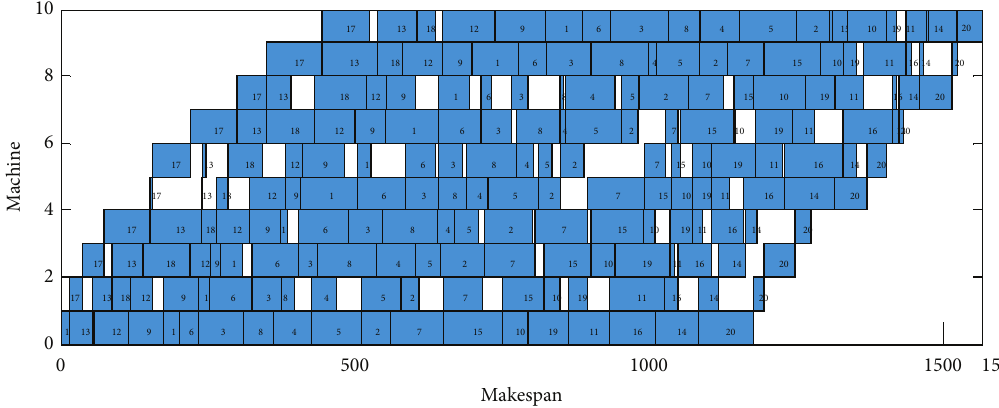
Figure 8: Gantt chart of an optimal schedule for Rec7, 𝜋 ∗ = [17,13, 18, 12, 9, 1,6, 3, 8, 4,5, 2, 7,15, 10, 19, 11, 16, 14, 20]